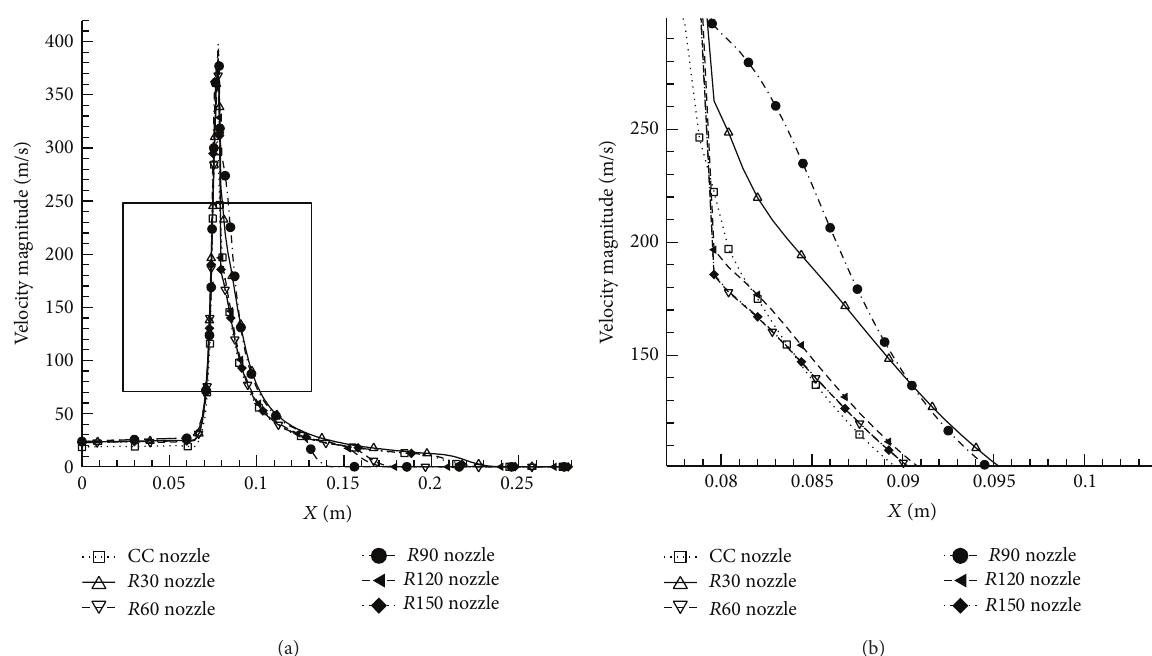
Figure 9: Jet velocity magnitude of preliminarily optimized CC nozzles compared with CC nozzle.